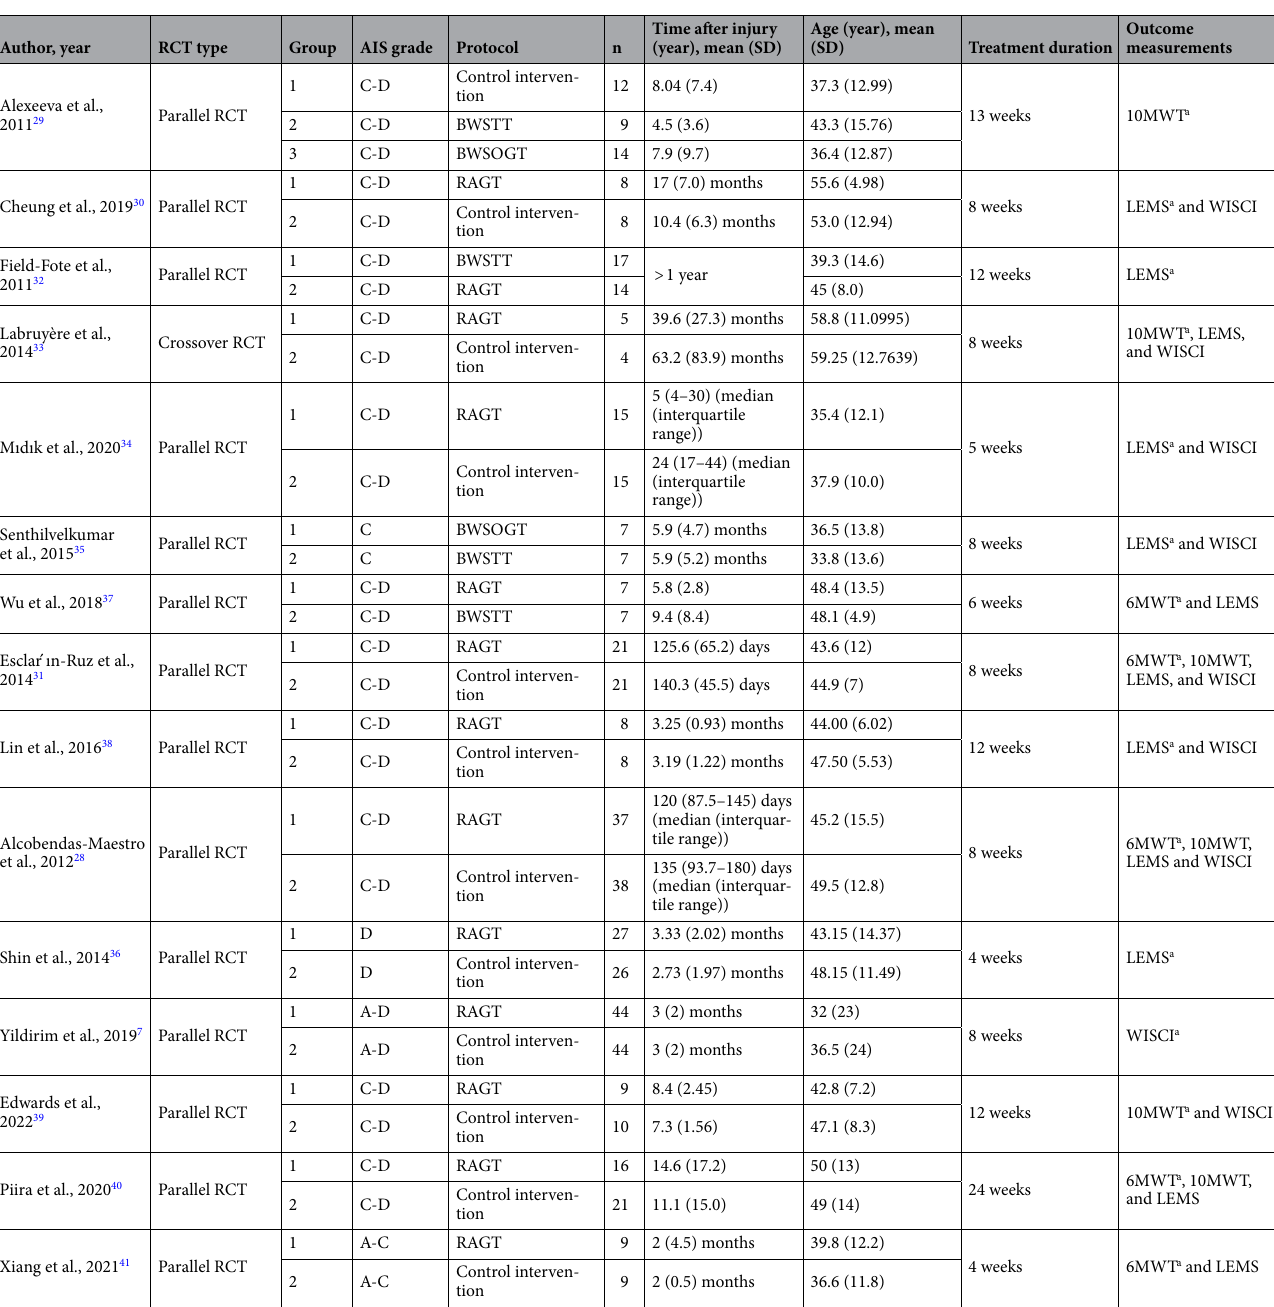
Table 1. Characteristics of the selected randomised controlled trials. a Outcome selected in this network meta-analysis. RCT, randomised controlled trial; AIS, American Spinal Injury Association Impairment Scale; SD, standard deviation; BWSTT, body weight-supported treadmill training; BWSOGT, body weight–supported overground training; RAGT, robot-assisted gait training; 10MWT, 10-m walk test; 6MWT, 6-min walk test; LEMS, lower extremity motor score; WISCI, Walking Index for Spinal Cord